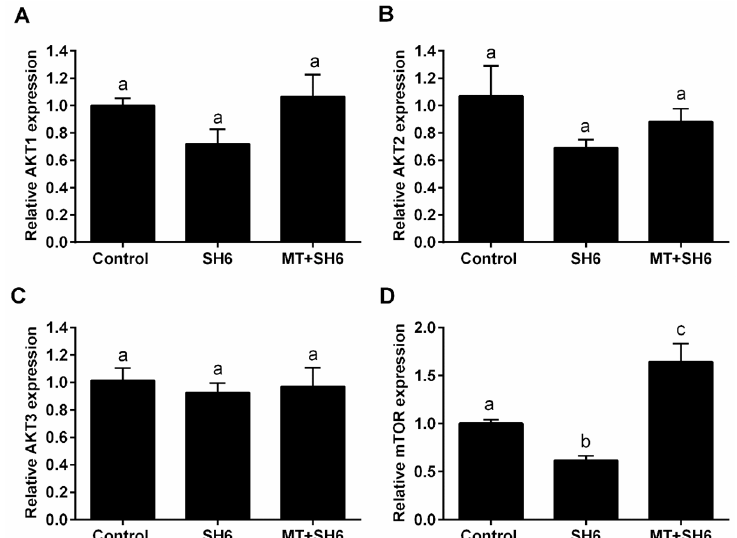
Figure 11. Relative expression of the mRNA of AKT signaling-related genes in oocytes. The mRNA from melatonin-SH6, SH6, and control groups was used for relative quantification of AKT1 ( A ), AKT2 ( B ), AKT3 ( C ), and mTOR ( D ). Superscripts with different letters indicate statistical significance ( p < 0.05).